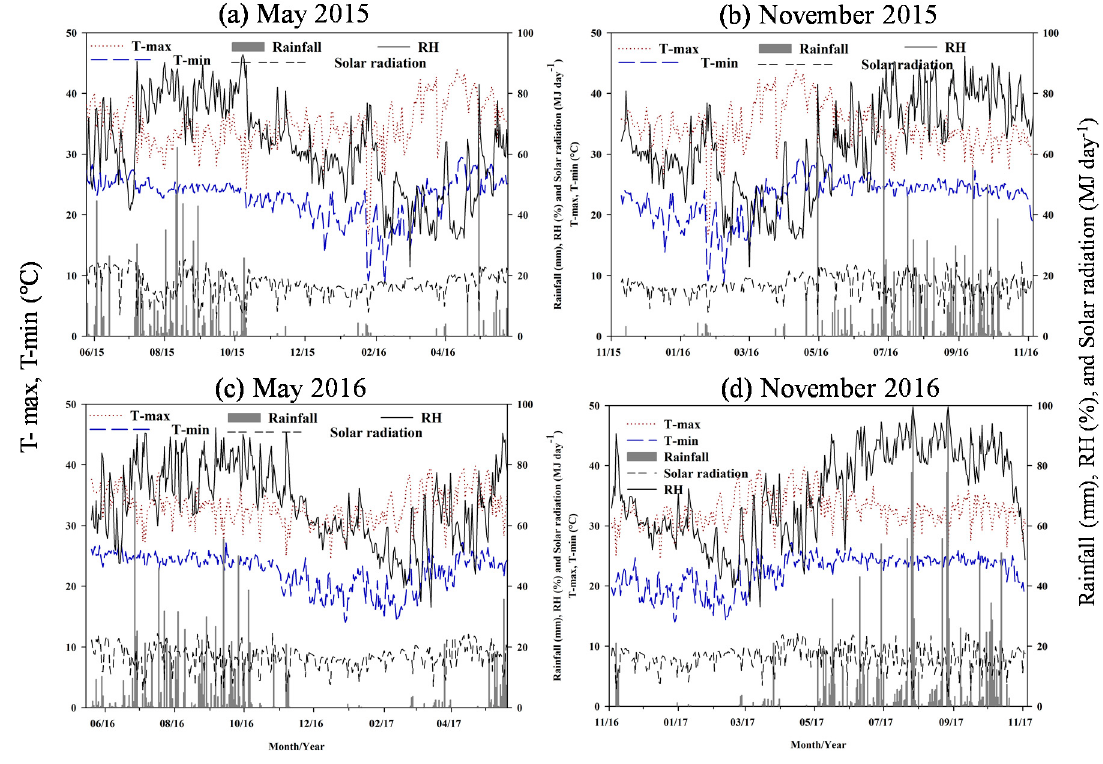
Figure 1. Maximum ( ··· ) and minimum (— —) temperature, rainfall ( ), relative humidity (—) and solar radiation (-- --) at Khon Kaen University, planting dates May ( a ) and November ( b ) 2015 and May ( c ) and November ( d ) 2016. Table 1. Monthly solar radiation (MJ m − 2 ) of Rayong 9 cassava under irrigated and rainfed conditions after planting in May and November 2015 and 2016. MAP, month after